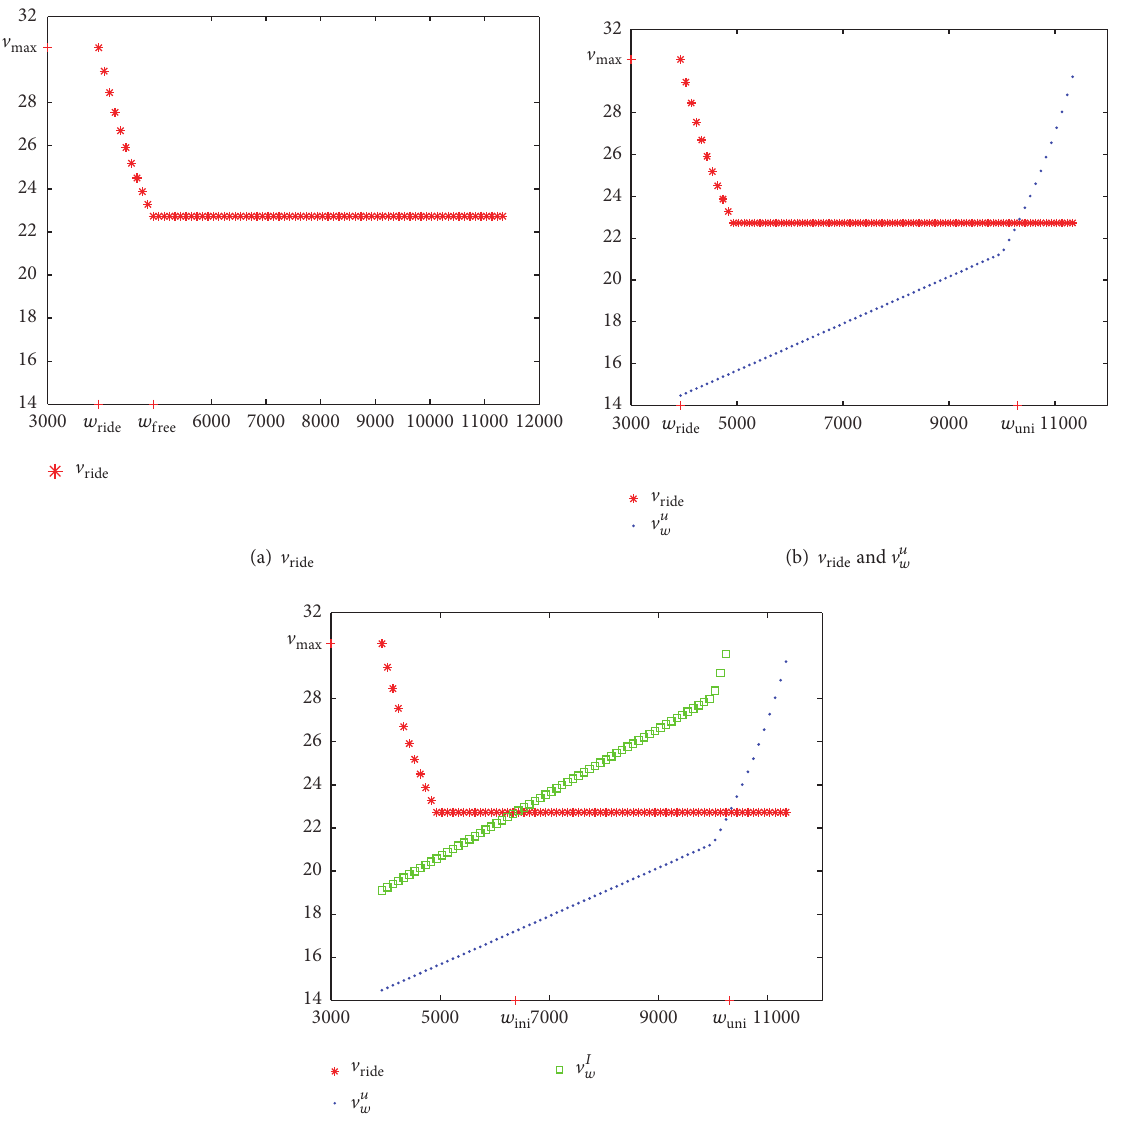
Figure 1: Speed functions as a function of 𝑤